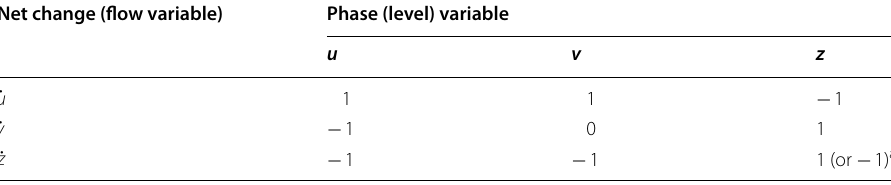
a 1 is for the first AHB with b critical = 150 > b 0 ; − 1 is for the second AHB with b critical = 0.6745